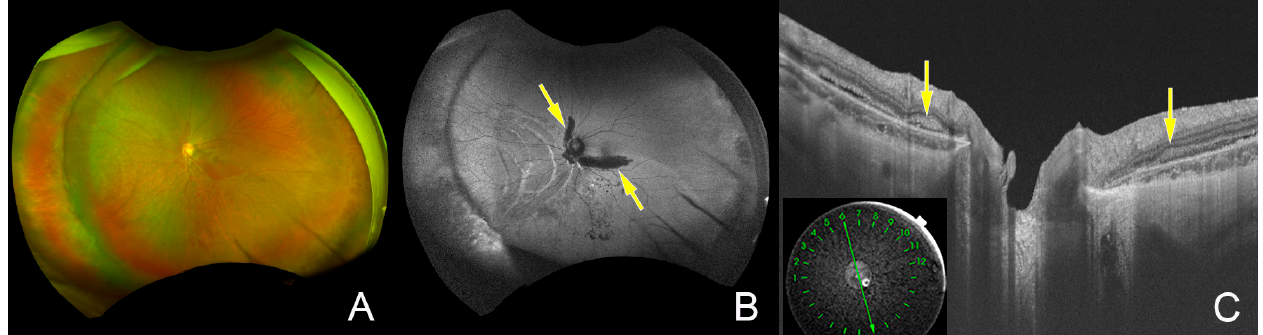
Figure 4. Postoperative widefield fundus photograph and FAF image. ( A ): The postoperative widefield fundus photograph shows that the atrophic retinal hole was located in the area indented by the buckle and the subretinal fluid was reduced. However, a subretinal hemorrhage was observed around the optic disc and the upper and lower arcade vessels. ( B ): Postoperative FAF image shows a hypo-FAF area (yellow arrows) corresponding to the subretinal hemorrhage, but no peripapillary starfish hypo-FAF was observed. ( C ): Postoperative optical coherence tomographic image showing hyperreflective subretinal hemorrhage (yellow arrows) near the optic disc.